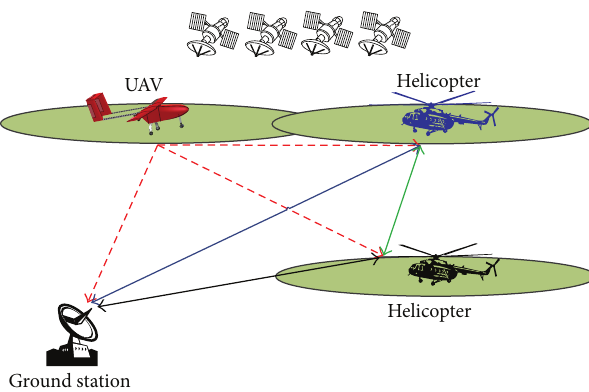
Figure 1: Architecture of UAV/CD&R using Quasi-ADS-B.